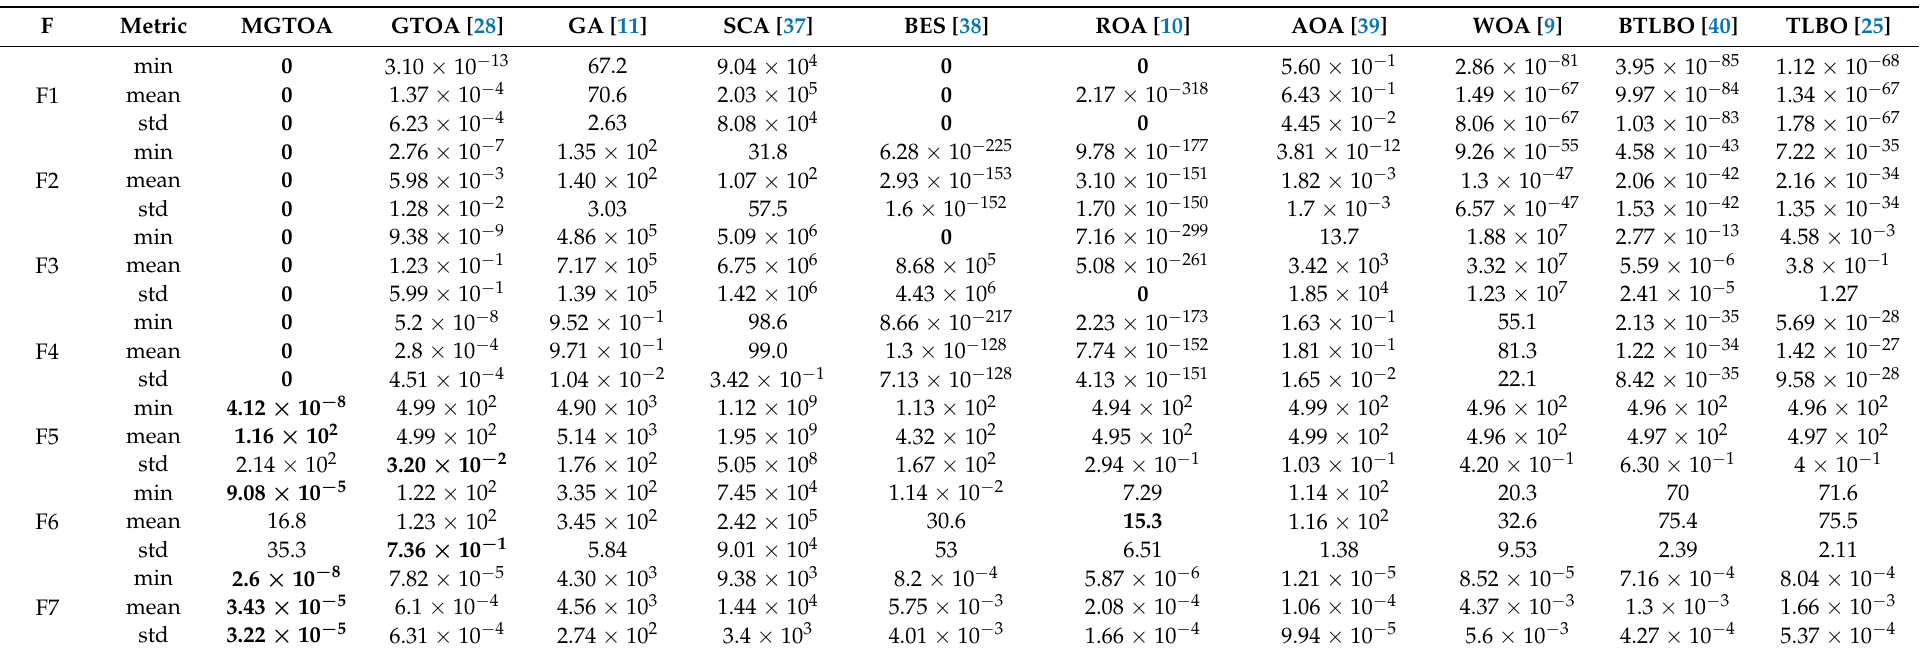
Table 4. Results of benchmark functions (F1–F13) under 500